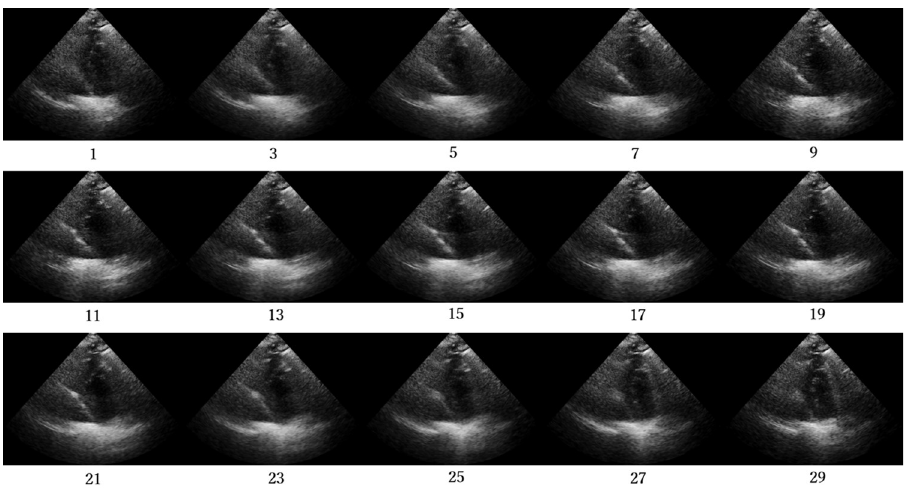
Fig 20. False-positive cases on short-axis view papillary muscle level